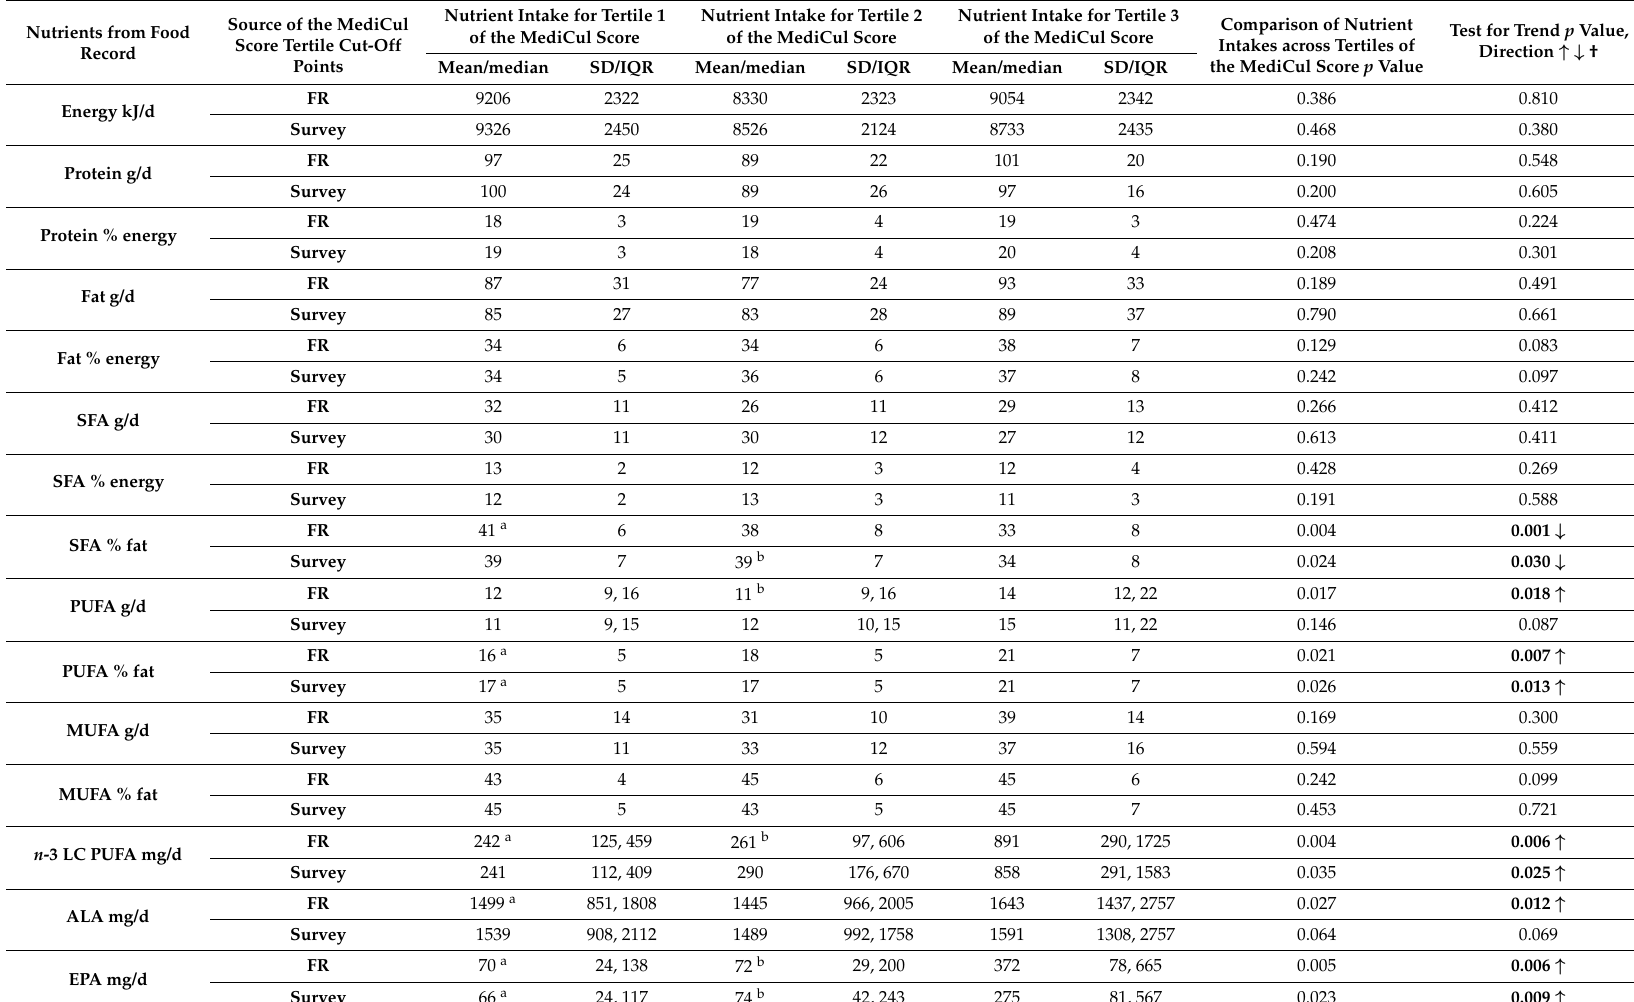
Table 3. Nutrient intakes compared with tertiles of the Mediterranean Diet and Culinary Index (MediCul) score from FR and survey A ( n = 71)